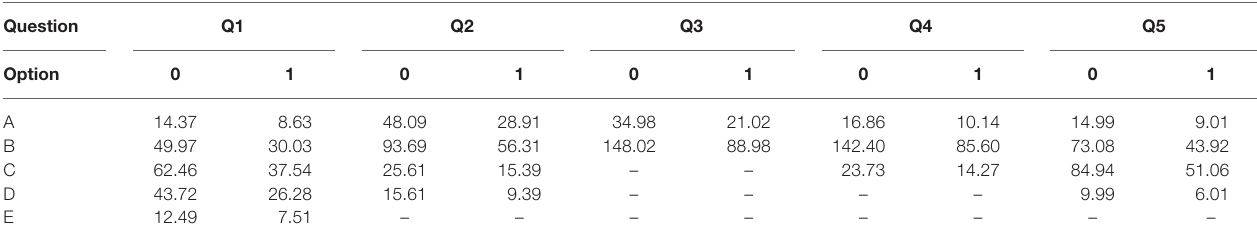
TABLE 9 | Expected frequency